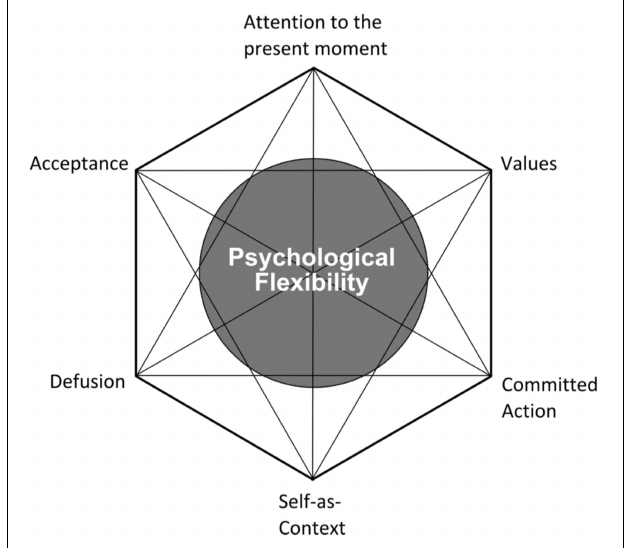
FIGURE 1 | The ACT Hexaflex (Batink et al.,